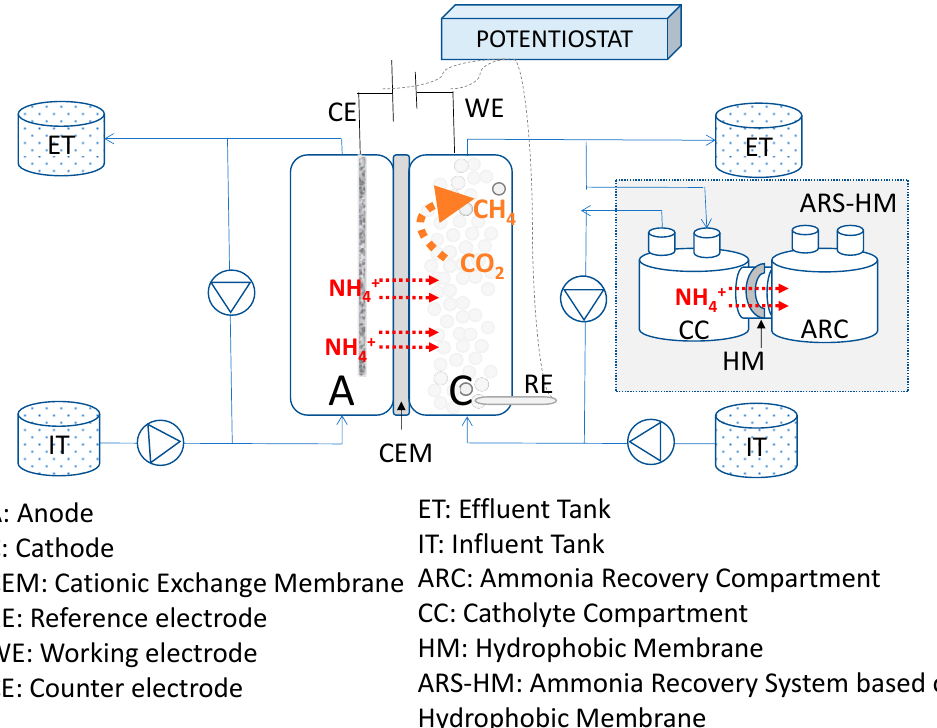
Figure 1. Schematic diagram of the set-up of the dual-chamber microbial electrolysis cells (MEC) with an electromethanogenic cathode and the ammonia recovery system based on hydrophobic membranes (ARS-HM) connected in the catholyte recirculation loop.